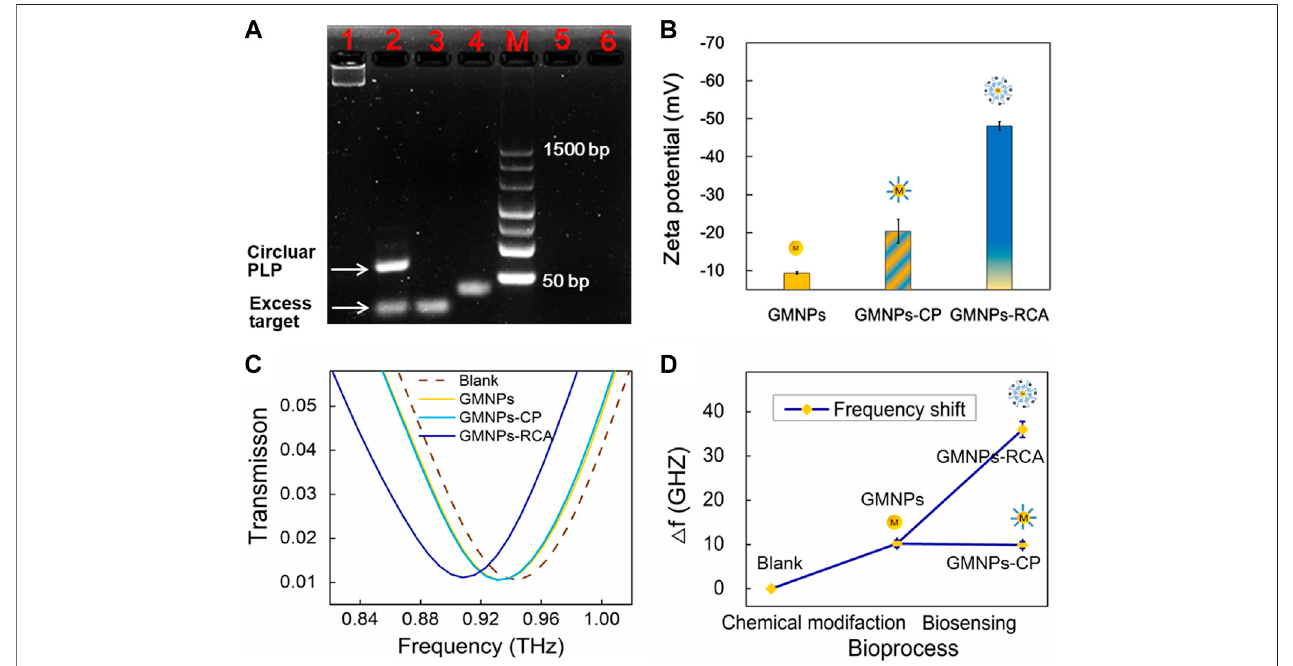
FIGURE 2 | GMNPs-RCA assay for HBV target sequence. (A) Electrophoretic identi fi cation of the ligation reaction mixture and RCA products. Lanes 1, 2, 3, 4, 5, and 6 represent the RCA products, ligation products (circular PLP), target, linear PLP, single-base mismatched sequences, and six-base mismatched sequences, respectively. (B) Zeta potential of GMNPs, GMNPs-CP, and GMNPs-RCA. Error bars indicate the SD ( n = 3). (C) THz measurements of the bare THz MM chip (Blank), GMNPs,GMNPs-CP, and GMNPs-RCA. (D) Thecorresponding THzfrequencyshifts( Δ f )of Figure2C .Errorbars indicate theSD( n =3). Δ f = f target – f withouttarget of which f represents the resonance peak